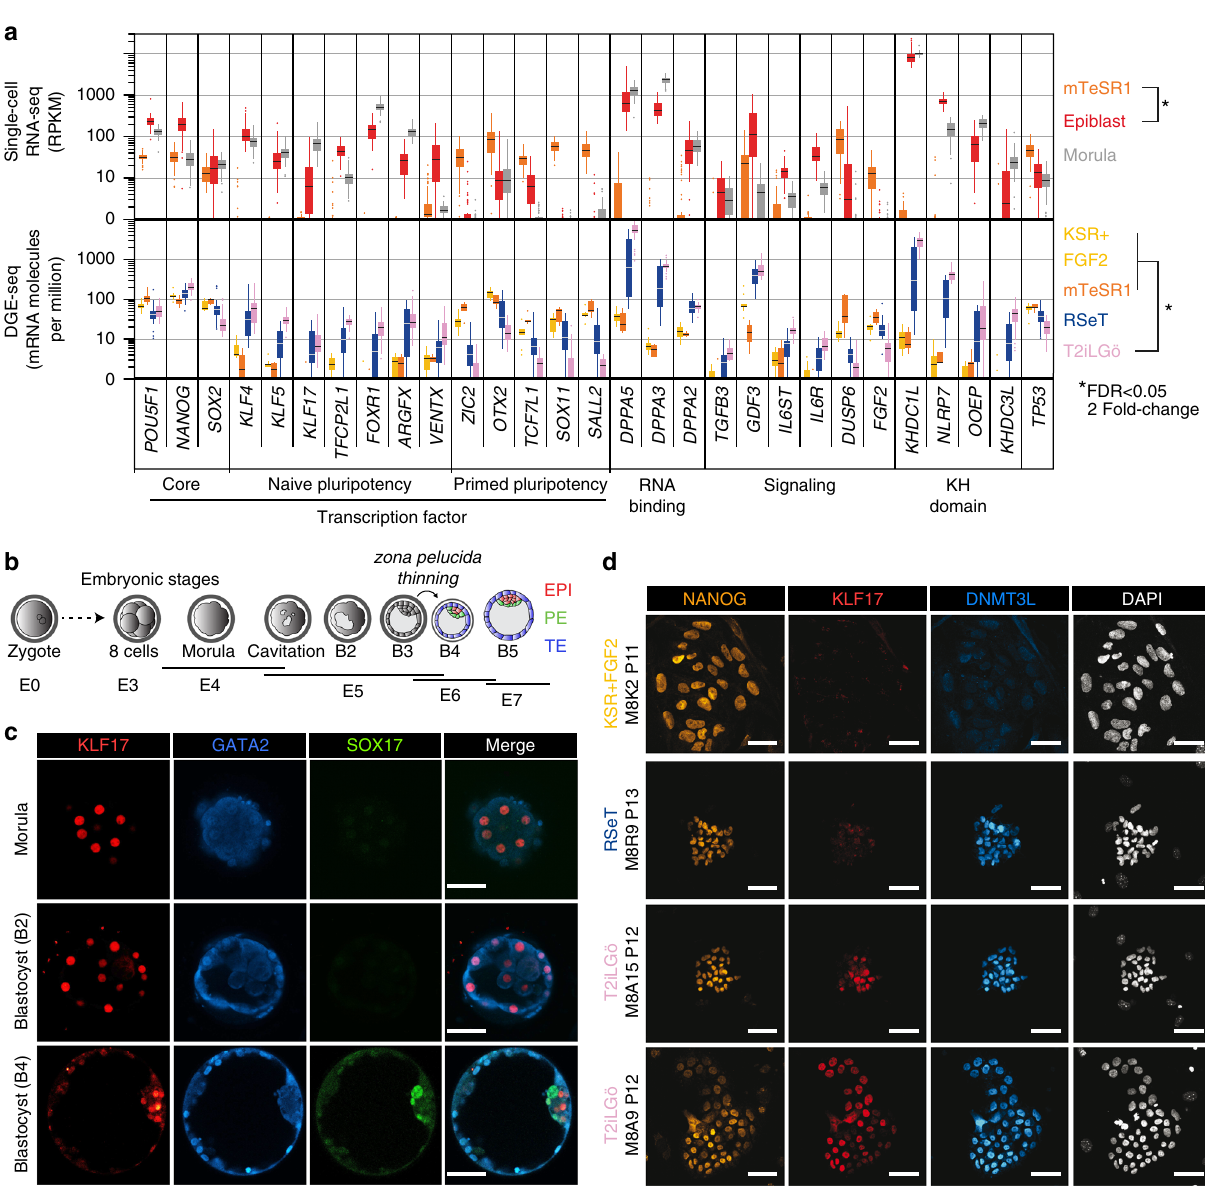
Fig. 2 hiNPSCs express markers speci fi c to human epiblast cells. a Speci fi c naive pluripotency markers display identical pro fi les in T2iLGö hiNPSCs and preimplantation epiblast cells. Individual differentially expressed genes plotted as RPKM for single-cell RNA-seq or mRNA molecules per million of total mRNA molecules for DGE-seq. Upper panel: all genes are differentially expressed (Epi vs primed), except SOX2 ; lower panel: all genes are differentially expressed (T2iLGö vs primed), except POU5F1(OCT4) and NANOG . Error bars are de fi ned as s.e.m. Statistical tests used to compute differentially expressed genes are de fi ned in the “ Differential Expression pro fi ling ” section of the Methods. b Schematic representation of the human preimplantation development comparing clinical staging (Morula, B2, B3, B4 and B5) with corresponding embryonic days (E). EPI epiblast cells in red, PE primitive endoderm cells in green; TE trophectoderm cells in blue. c KLF17 protein is expressed in all morula cells before being restricted to epiblast cells in the blastocyst. Human embryos were cultivated in a time-lapse microscope and fi xed at indicated stages (morula, B2 or B4 blastocysts). Immuno fl uorescence for KLF17 (red), GATA2 (blue) and SOX17 (green) was performed. For each indicated embryonic stage, immuno fl uorescence was performed on 3 biological replicates. Scale bar = 50 µ m. d KLF17 protein is speci fi cally expressed in T2iLGö hiNPSCs (pink) and not in isogenic lines cultivated in RSeT (blue) and KSR-FGF2 (yellow). Indicated cell lines were analyzed by immuno fl uorescence for NANOG (yellow), KLF17 (red) and DNMT3L (cyan). This fi gure is representative of 8 biological replicates. Scale bar = 50 µ pluripotent stem cells, the second discriminating between H1 and We analyzed our hiNPSC and hiPSC lines, at different H9 on one side and HNES1 on the other side (Fig. 1c). T2iLGö passages, by 3 ′ digital gene expression RNA-sequencing (DGE- and RSeT hiNPSC lines were separated along the second principal seq), a quantitative method based on molecular indexing of component. The majority of T2iLGö hiNPSCs clustered with messenger RNA (mRNA) molecules 27,28 . Controls used in this analysis are primed (H1 and H9) and naive (HNES1) hESC HNES1, regardless of passage number, while cells exposed to lines 19 . Principal component analysis (PCA) revealed two major RSeT formed two intermediate clusters and tended to become components: the fi rst discriminating between parental cells and more similar to primed human PSCs (hPSCs) at later passages